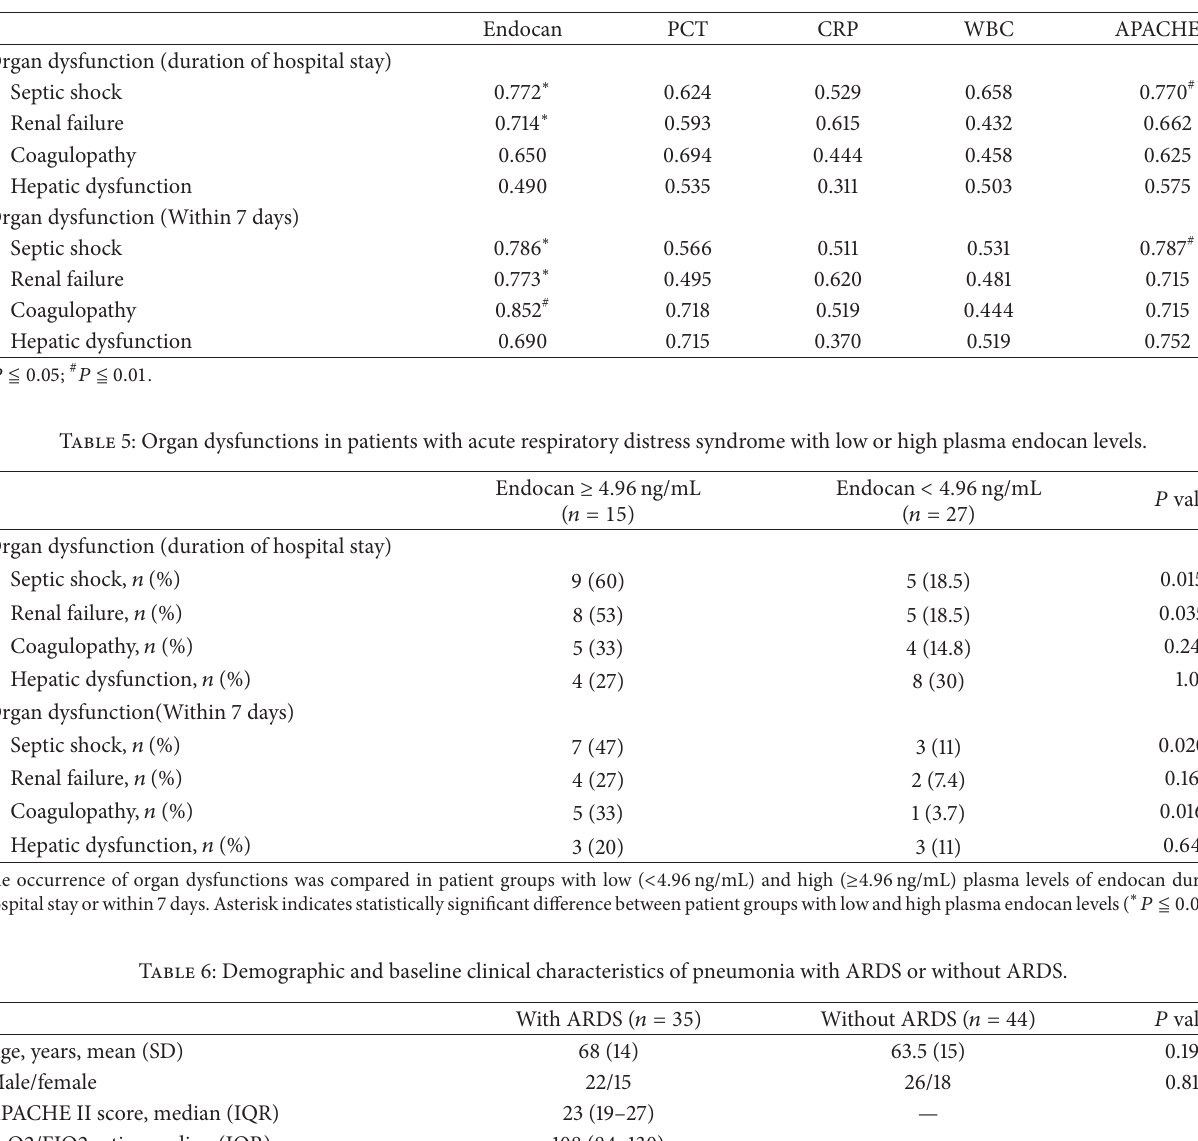
Table 4: Areas under receiver operating characteristic curves for plasma biomarker levels in predicting organ dysfunction in patients with acute respiratory distress syndrome.